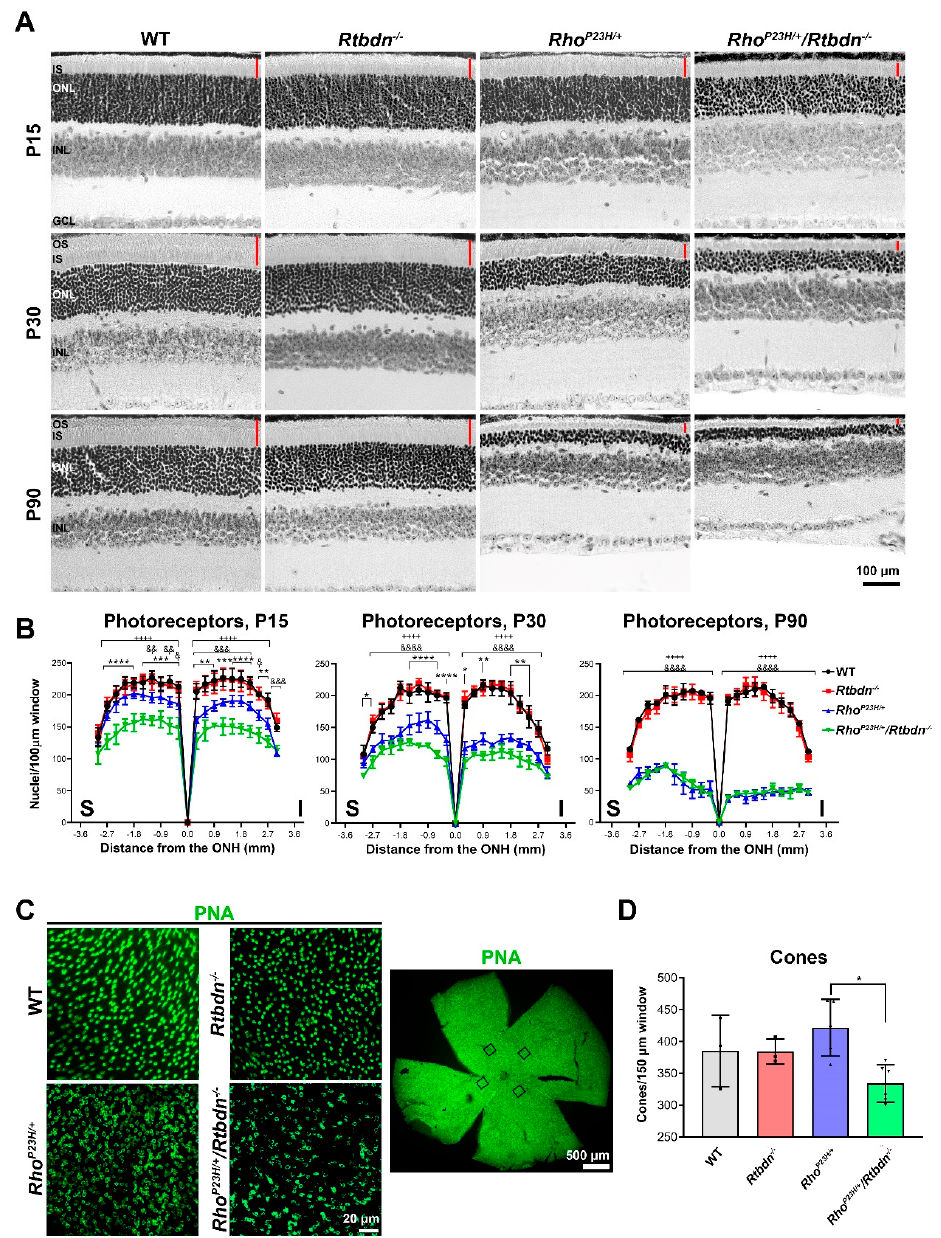
Figure 3. Eliminating Rtbdn exacerbates retinal degeneration in the Rho P23H/+ retina. ( A ) Light microscopic images of hematoxylin and eosin (H&E) stained retinal sections from retinas of the indicated genotypes and ages. Red bars highlight the IS/OS layer. ( B ) Photoreceptor nuclei were counted across the superior-inferior plane from retinas at P15, P30, and P90 and plotted in spidergrams (mean ± SD, n = 3 eyes/genotype/age). + indicates comparison between wild type (WT) and Rho P23H/+ /Rtbdn − / − , & indicates comparison between WT and Rho P23H/+ , and * indicates comparison between Rho P23H/+ and Rho P23H/+ /Rtbdn − / − . One symbol, p < 0.05, two symbols, p < 0.01, three symbols, p < 0.001, and four symbols, p < 0.0001 by two-way ANOVA with Sidak’s post-hoc test. ( C ) Cone photoreceptors were labeled with PNA (green) in P30 retinal whole mounts from the indicated genotypes. Left side shows example of counted region from the whole mount. Example wholemount highlighting four counted areas is shown on the right. For quantification, 4 independent images were captured at the same distance from the optic nerve head for each retina and ( D ) cone counts for these 4 images were averaged to give a value for each sample. n = 3–6 retinas / genotype. Data presented as mean SD. * p < 0.05 ± by Kruskall–Wallis test with Dunn’s multiple comparison test. Symbols represent individual